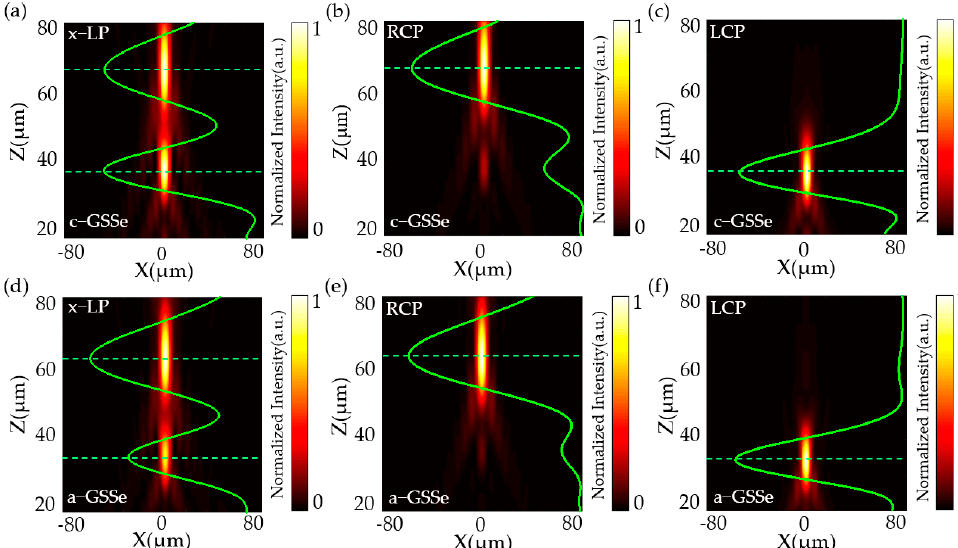
Figure 3. The intensity of the simulated electric field under three distinct polarization excitations When the GSSe phase change material is in the crystalline (x − LP ( a ), RCP ( b ), and LCP ( c )) and amorphous (x − LP ( d ), RCP ( e ), and LCP ( f )) states.